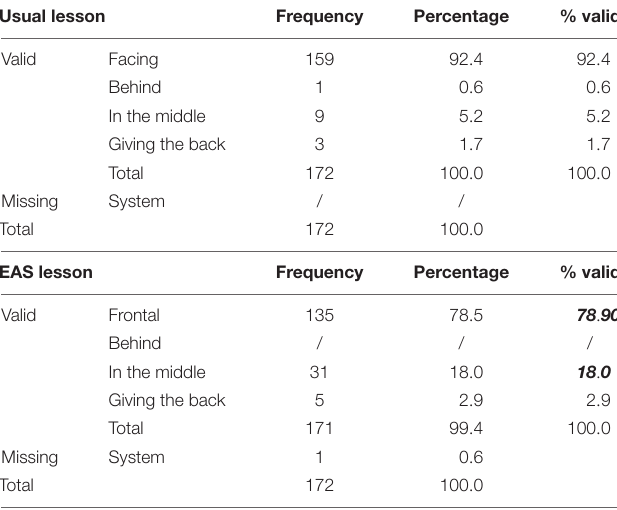
TABLE 10 | Differences in active participation between usual lessons and EAS